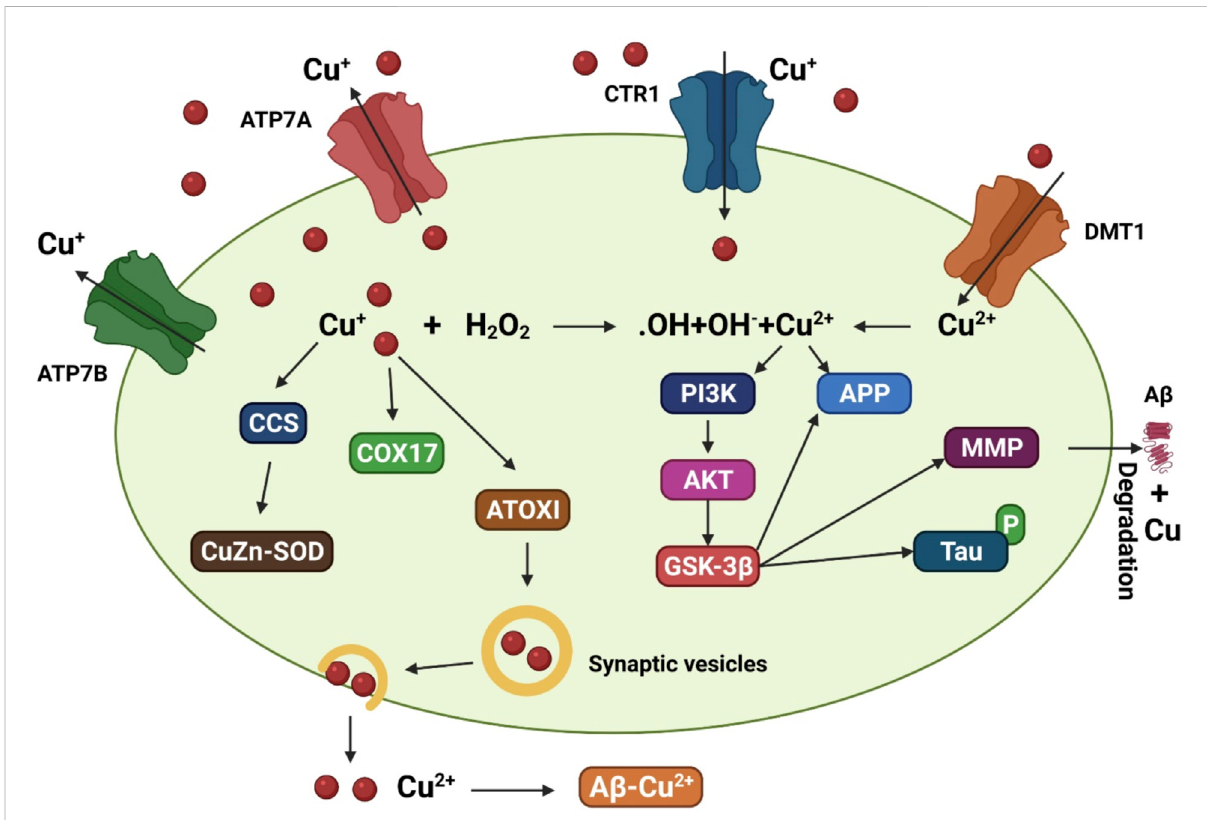
FIGURE 2 AmodelthatdepictsthecoppertransitsystemanditslinktoAD.Coppertransporter1(CTR1)transportsCu + intobraincells.Cu 2+ uptakeisaided by DMT1. Various Cu chaperones, including such copper chaperone for superoxide dismutase (CCS), cytochrome oxidase enzyme complex (COX17), and antioxidant protein (ATOX1), sequester accumulated Cu into particular cellular sites. ATOX1 is thought to transfer Cu + to ATP7A (copper-transporting P-type ATPase) and ATP7B, which aid in the import of Cu + into synaptic vesicles for release and/or facilitate Cu export straightforwardly. Increased oxidative stress may be caused by excessive intracellular Cu + activating the Fenton reaction. Cu 2+ also leads to tau hyperphosphorylation by stimulating the glycogen synthase kinase 3 β (GSK3 β ) pathway, which is implicated in the production of the matrix metalloproteinases (MMP) important for A β breakdown. Copper interacts to A β in the synaptic cleft, facilitating the production of senile